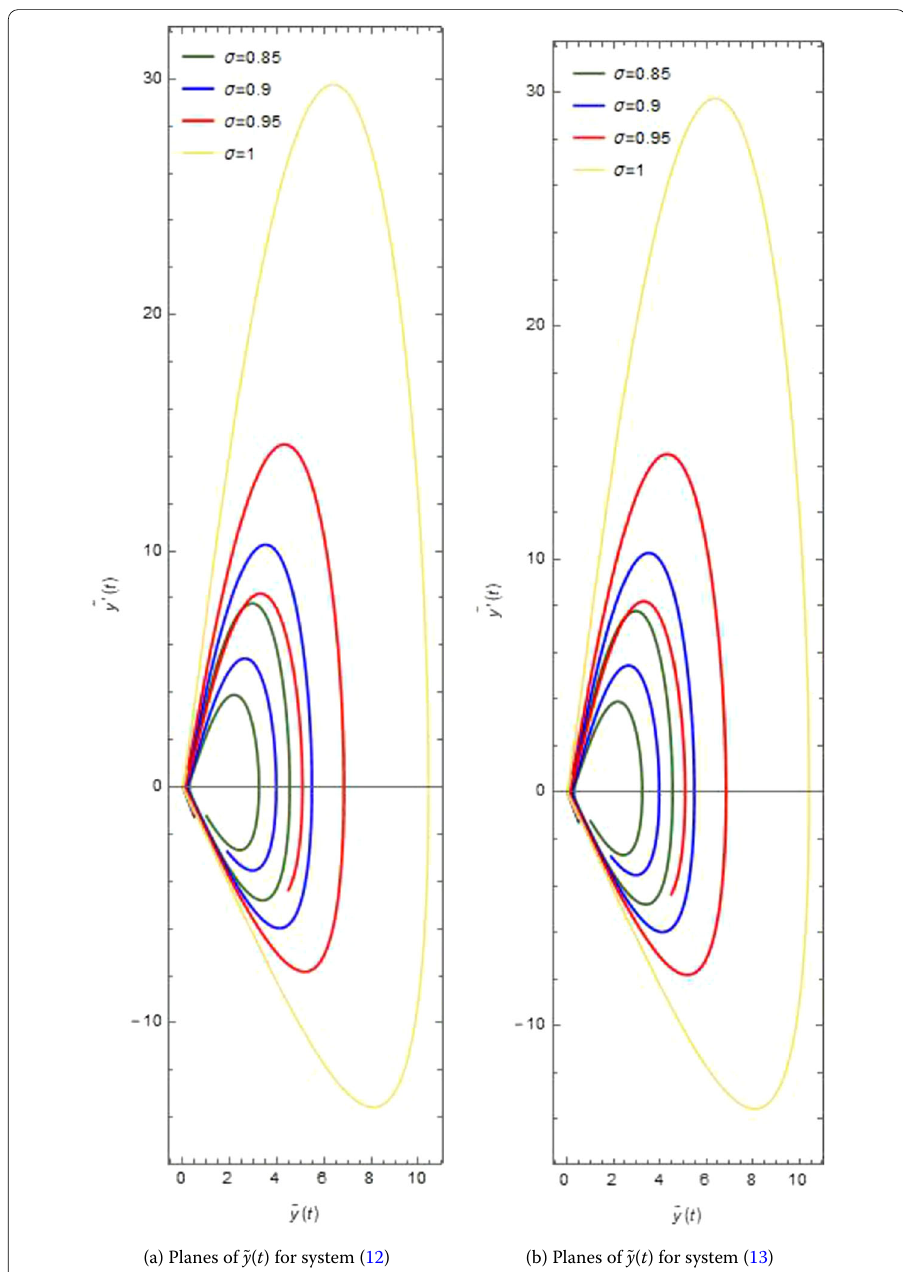
Figure 7 Phase planes for α = 1, q 1 = 0.2, q 2 = 0.7, t ∈ [0,10] and E =